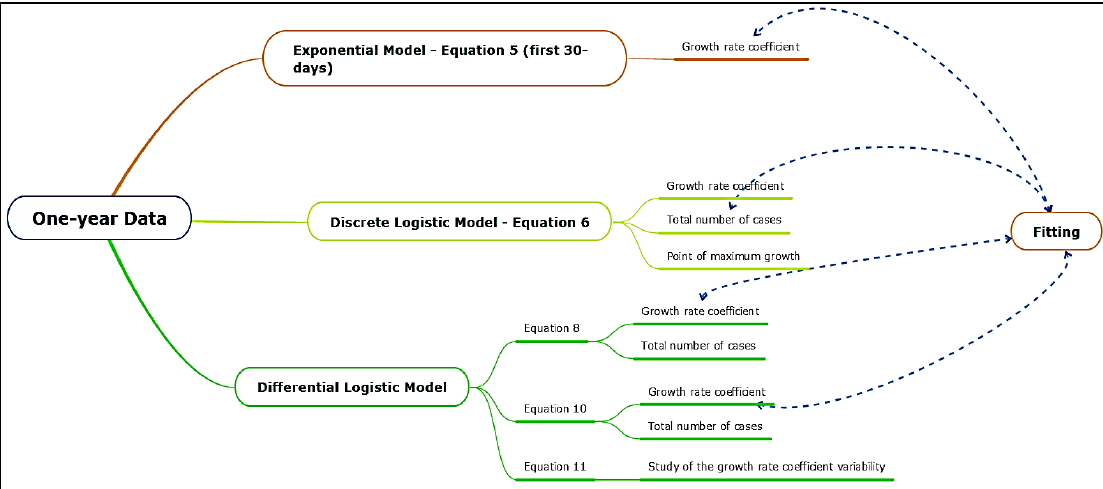
Figure 2. Schematic representation of the research